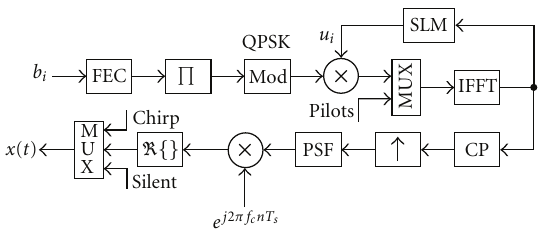
Figure 1: Proposed transmitter structure, where the operator (cid:3) represents the real part of the